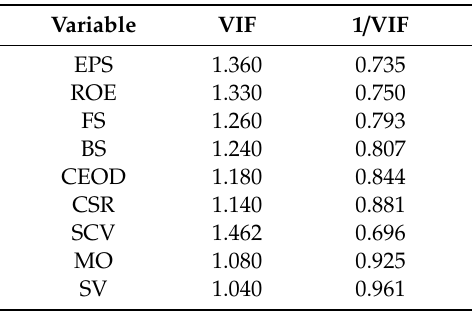
Table 3. Test for